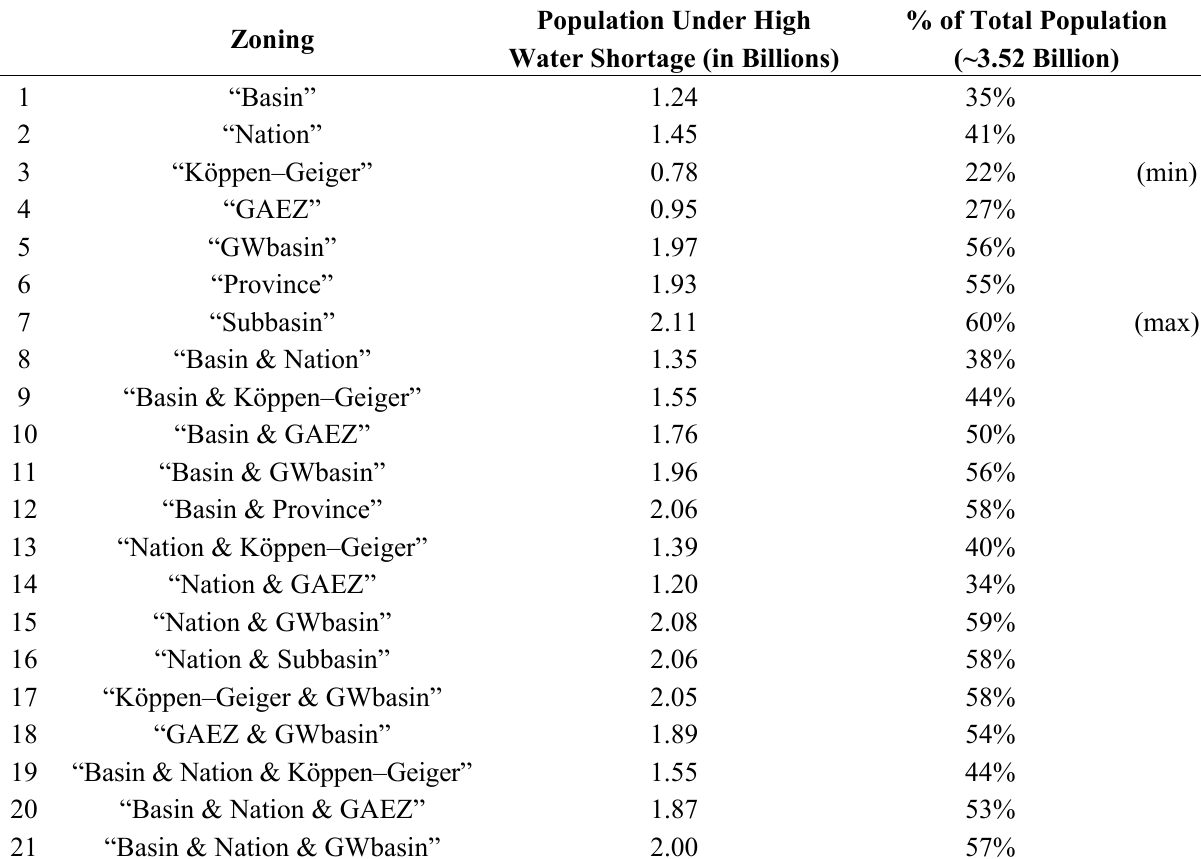
Table 2. Population under high water shortage (water availability <1000 m 3 /cap/year) per each